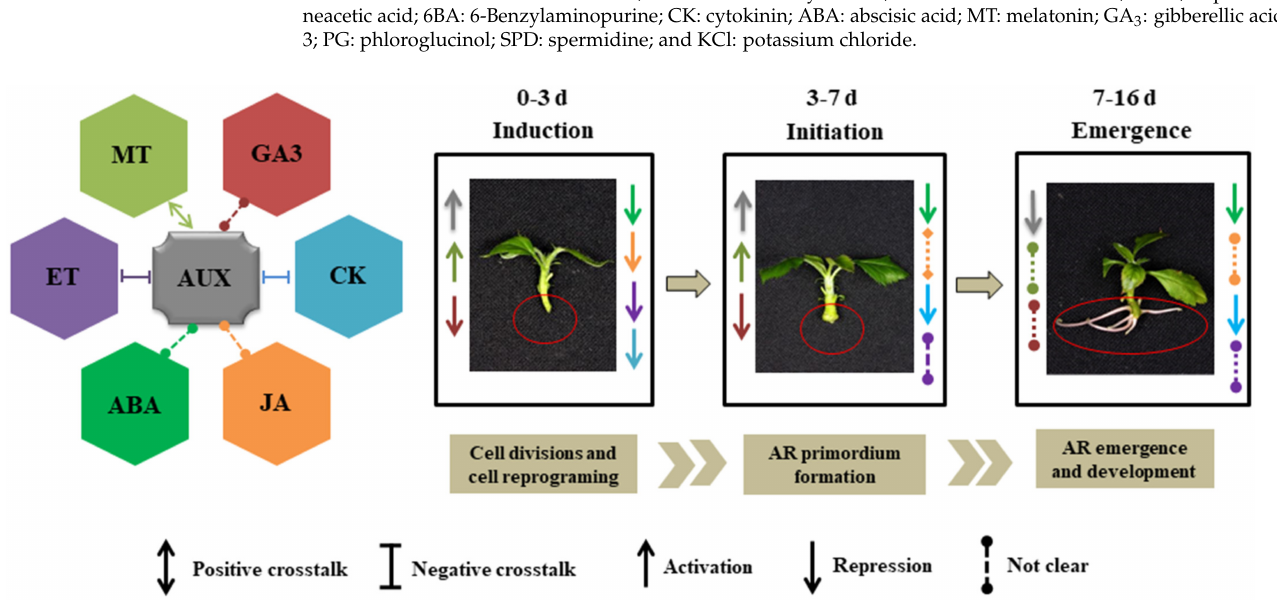
Figure 1. A suggested schematic diagram of adventitious root (AR) formation stages (0–3 day, AR induction phase; 3–7 day, AR initiation phase; and 7–16 day, AR emergence phase) influenced by endogenous hormones in apples: Auxin (AUX), abscisic acid (ABA), cytokinin (CK), melatonin (MT), jasmonic acid (JA), ethylene (ET) and gibberellic acid 3 (GA 3 ). Different colors show specific hormone activities. Different arrow heads show different